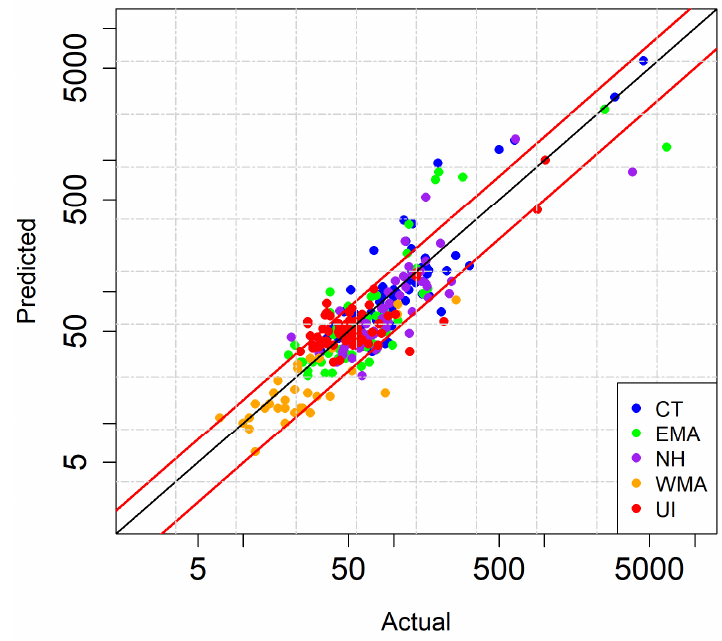
Figure 2. Actual outages vs. predicted outages for the OPM.